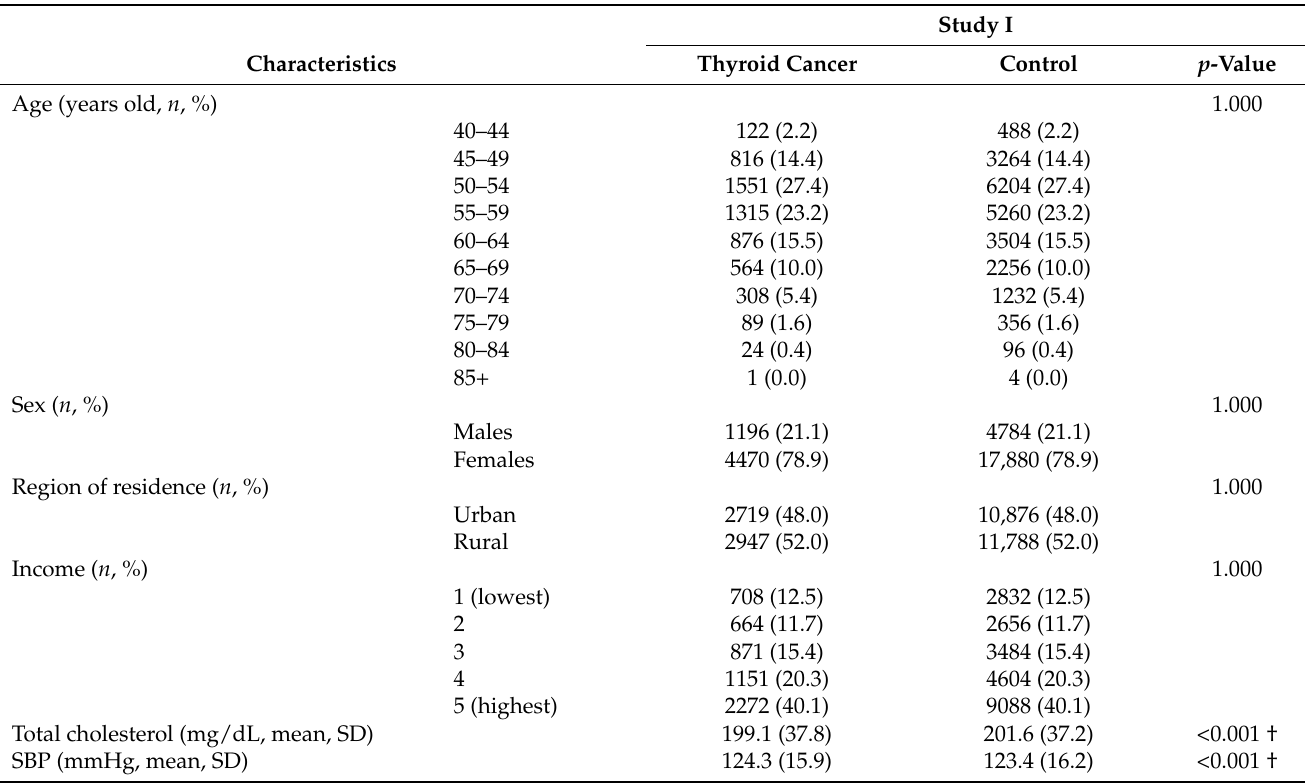
Table 1. General characteristics of participants of Study